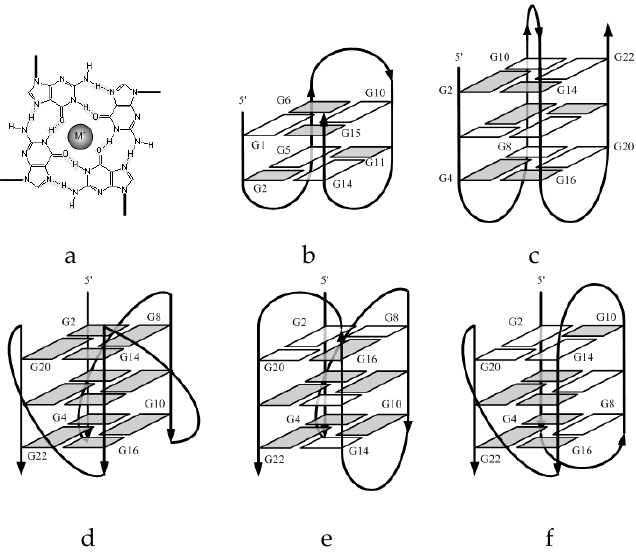
Figure 1. Schematic representations of intramolecular G-quadruplex (G4) structures: ( a ) a G-quartet plan with a coordinated ion, ( b ) antiparallel chair-type G4 of TBA sequence d[GGTTGGTGTGGTTGG] in K + solution [39], ( c ) antiparallel basket-type G4 of telomeric sequence d[A(GGGTTA) 3 GGG] in Na + solution, ( d ) parallel propeller-type G4 of telomeric sequence d[A(GGGTTA) 3 GGG] in a K + -containing crystal, ( e ) hybrid (3 + 1) type 1 G4 structure for d[TA(GGGTTA) 3 GGG] in K + solution, and ( f ) hybrid (3 + 1) type 2 G4 structure for d[TA(GGGTTA) 3 GGGTT] in K + solution [40]. The anti and syn guanine residues are colored grey and white, respectively.